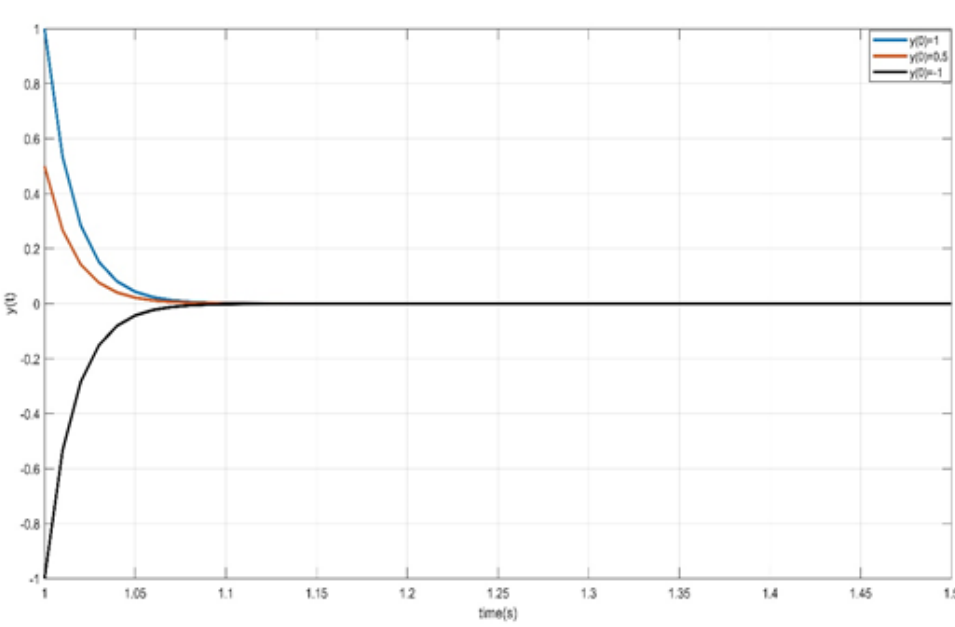
Figure 2. The paths of y ( t ) solutions of continuous and discrete scalar IDDE (13), which are bounded for different initial values, y ( 0 ) = − 1, y ( 0 ) = 0.5 and y ( 0 ) =